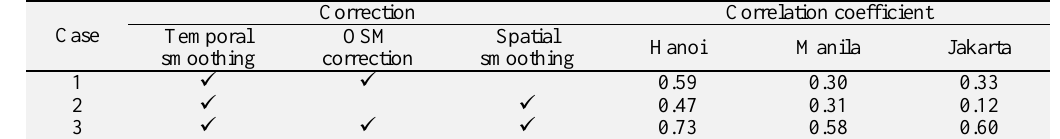
Table 3. Comparison of correlation coefficient according to combination of each correction